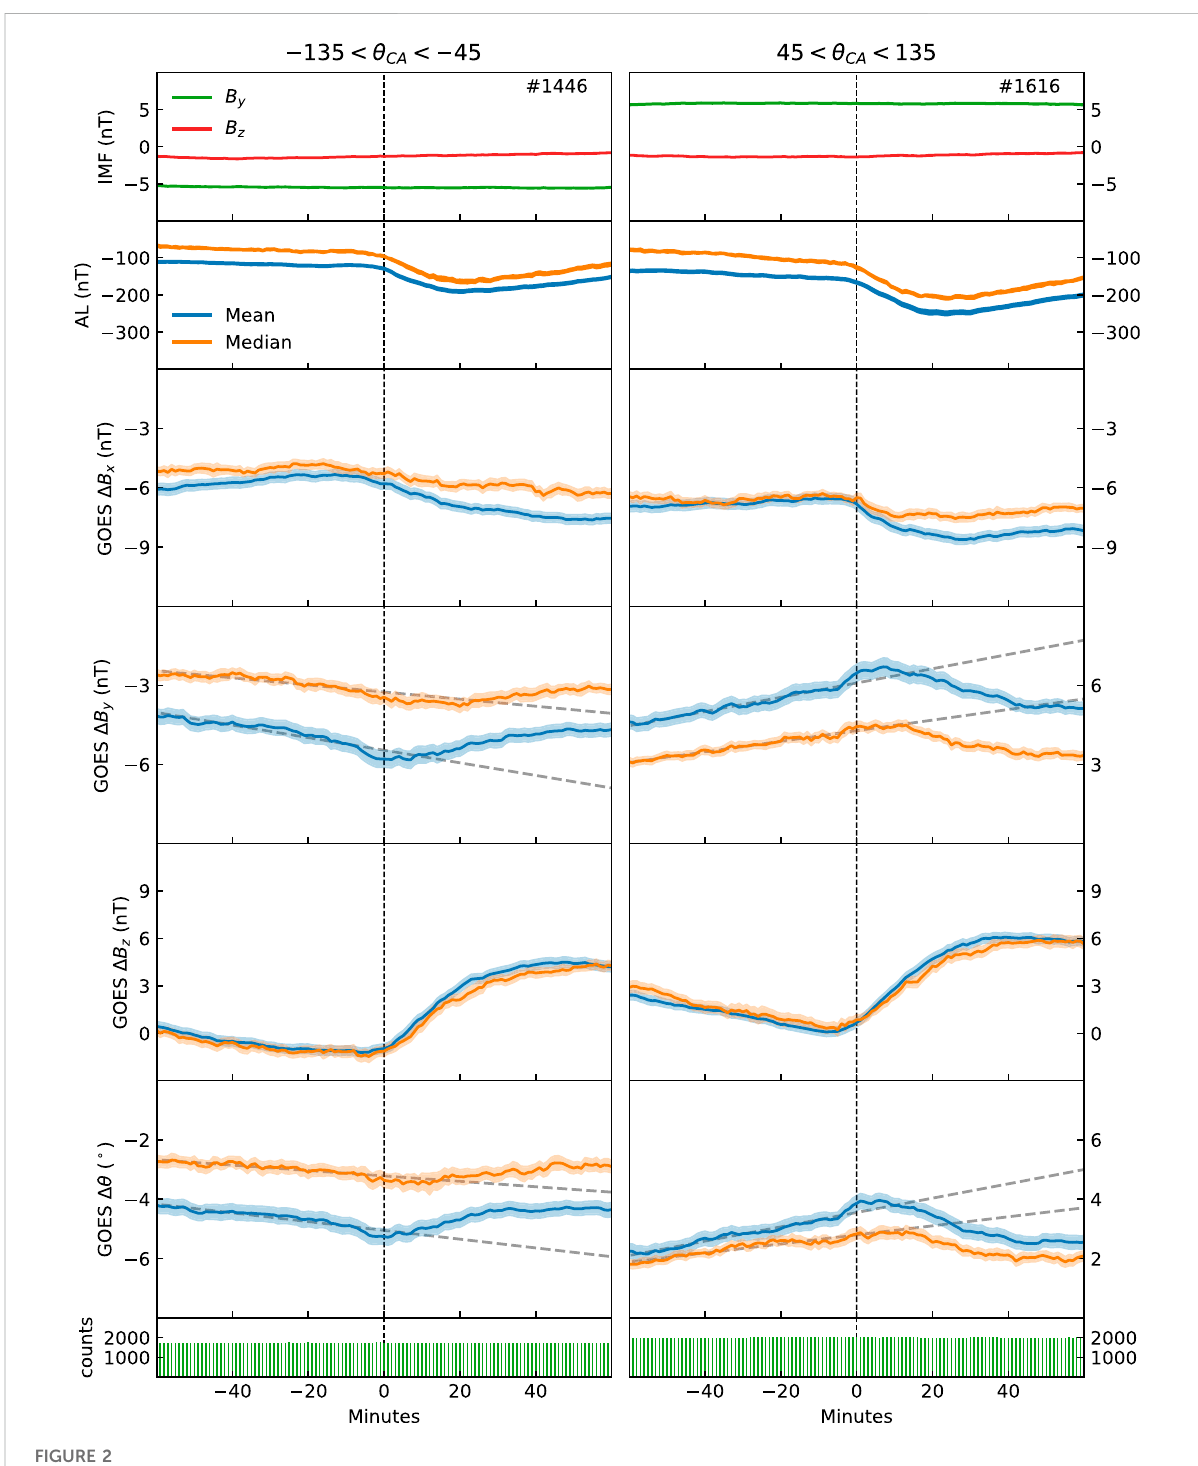
FIGURE 2 Superposed epoch analysis relative to substorm onset as identi fi ed by the McP&C onset list, format as Figure 1.